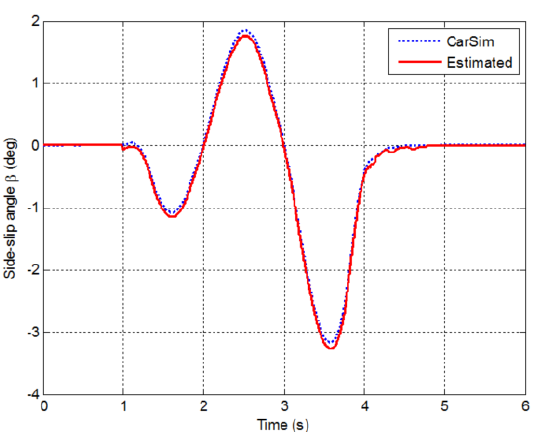
Fig. 10: Estimation of the vehicle side-slip angle for any condition of steering